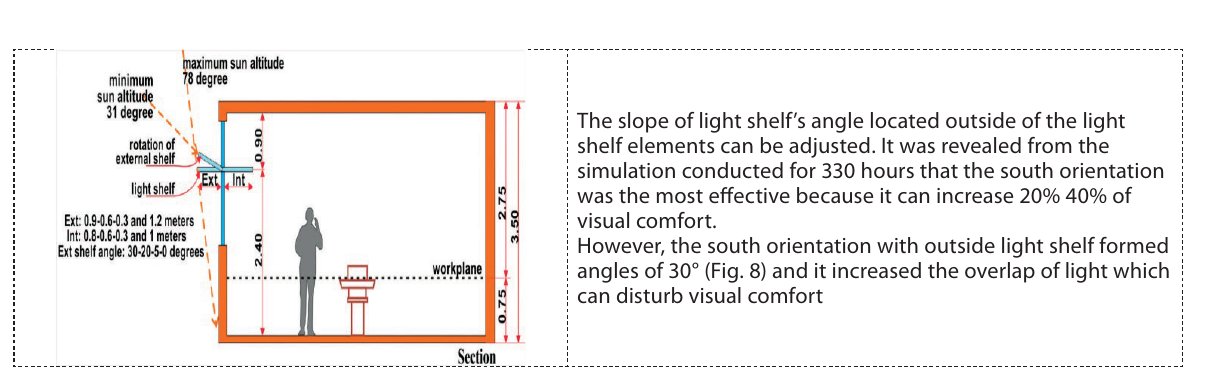
Fig. 8. Daylighting utilization